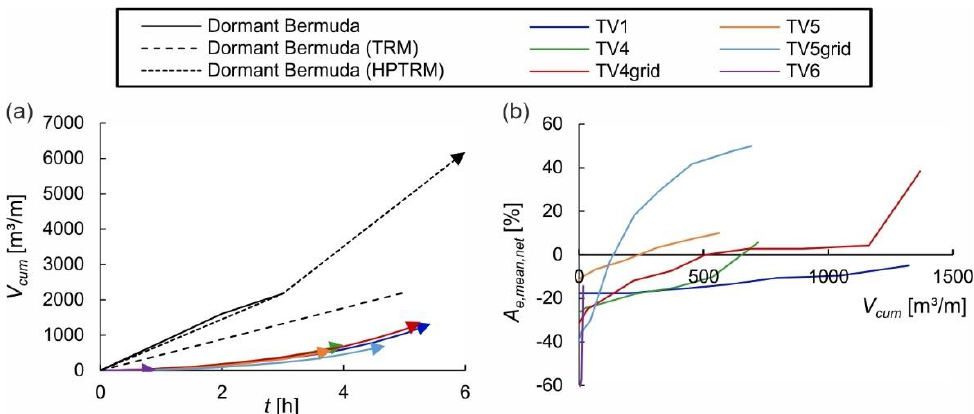
Figure 11. ( a ) Cumulative overflow volume V cum plotted against the testing time t for the different vegetated slopes with comparison to data on dormant Bermuda grass on clay soil from literature (black lines) [40], arrows indicate that no failure of the dike cover occurred. ( b ) Mean net percentage of eroded area A e,mean,net , defined as the percentage of eroded area under consideration of the vegetation coverage A e,mean,net = A e,mean −(100− c veg ), as mean value along the 1:3 slope as function of the cumulative overflow volume V cum for the different vegetated covers. TV1 = species‐poor grass‐dominated mixture, TV4 = grass-herb mixture, TV5 = species‐rich herb‐dominated EcoDike mixture, TV6 = species-rich herb-dominated ready-mix, and grid = geogrid reinforcement.